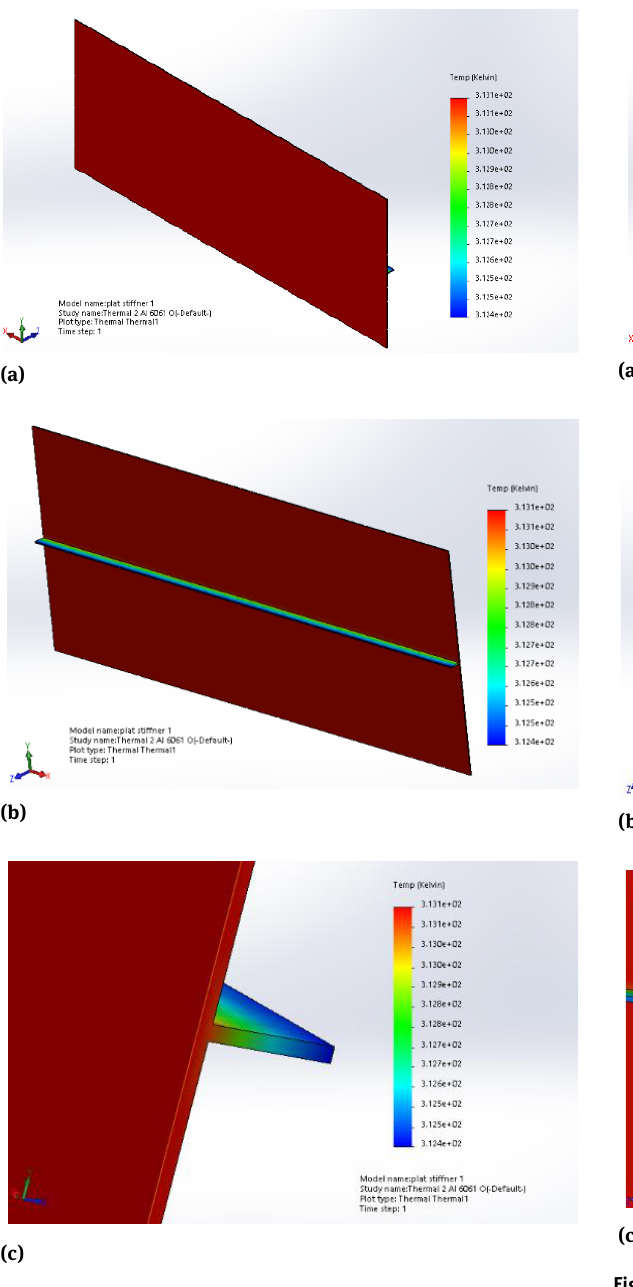
Figure 24: Result of the thermal simulation for the flat wall with a single stiffener: (a) outer surface, (b) inner surface, and (c) edge